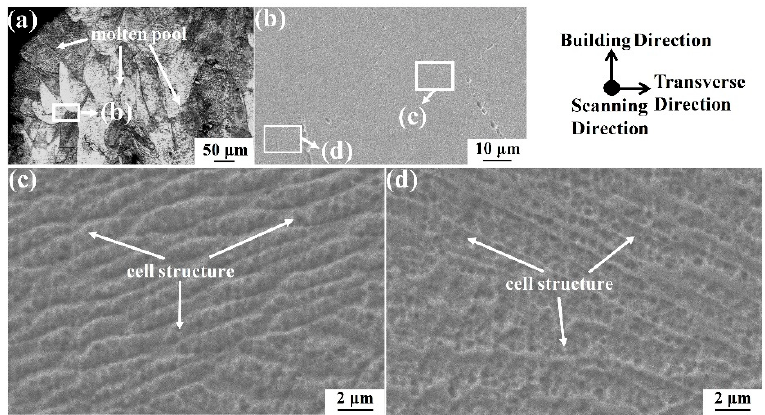
Figure 7. ( a ) Optical micrograph and ( b ) SEM micrograph of the 316L stainless steel Type II lattice structure fabricated via SLM revealing the morphology of molten pool. ( c ) ( d ) SEM micrographs showing the observed cell structure can be formed at the boundary of the molten pool and other areas. Two kinds of substructures consist of cell structures: strip-like substructures and spherical substructures.